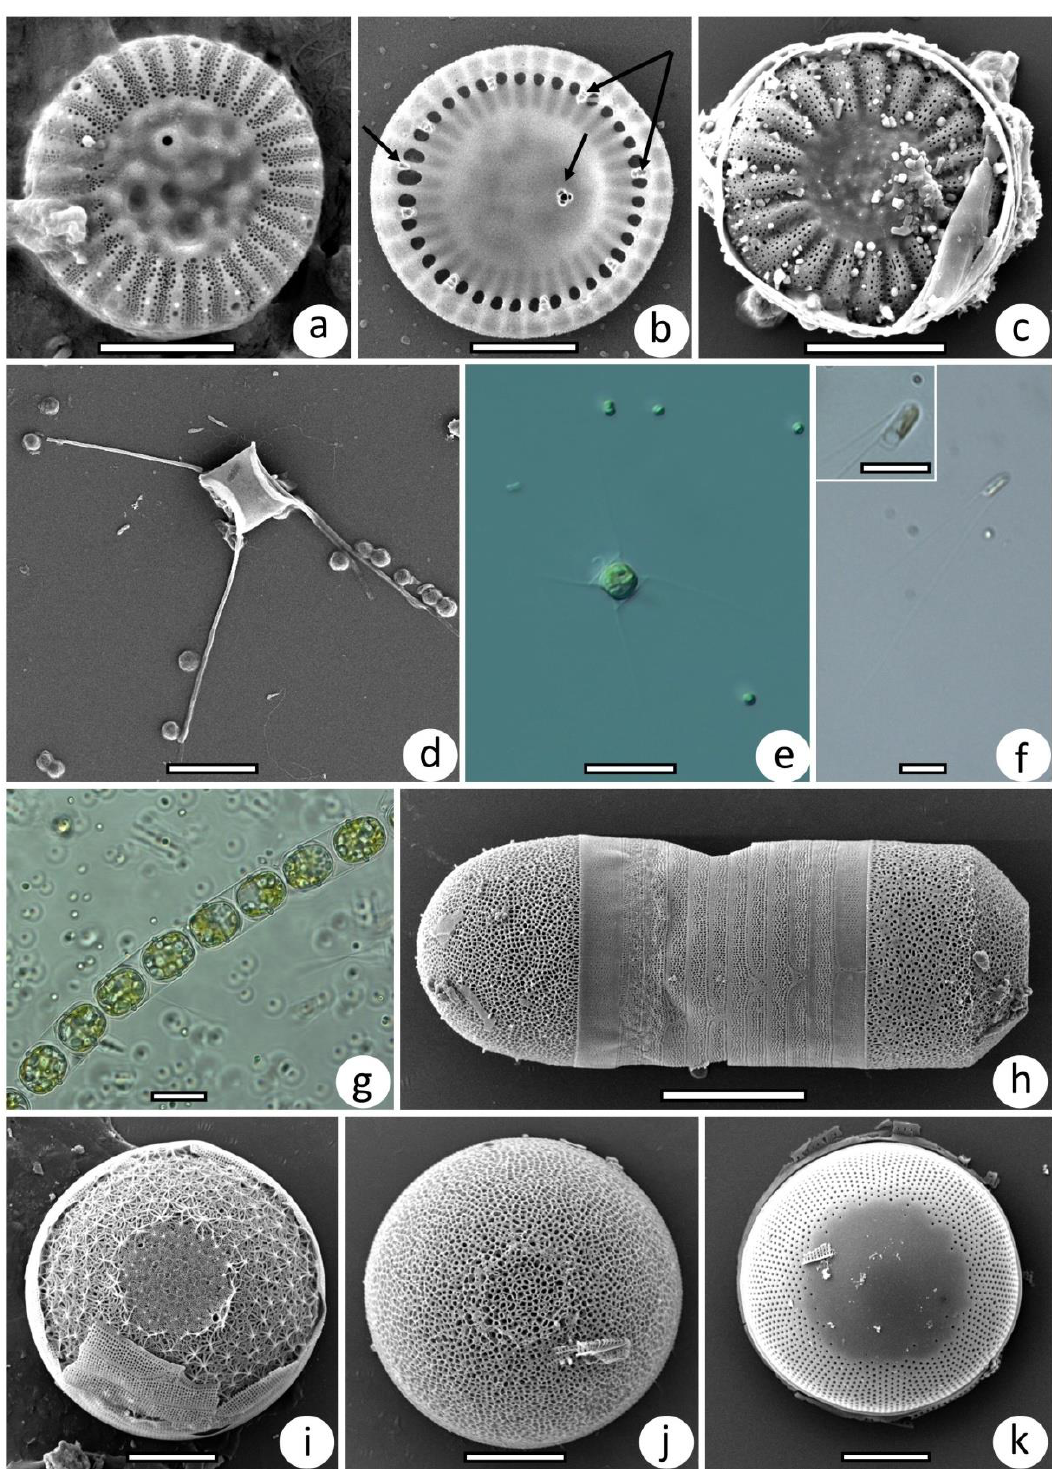
Figure 7. Morphology of the diatoms observed (LM ( e – g ); SEM ( a – d , h – k ): ( a , b ) Cyclotella choctawhatcheeana ( a — external view of valve; b — internal view of valve, arrows indicate central fultoportula with three satellite pores, marginal fultoportulae with two satellite pores, and rimoportula (arrow on the left)); ( c ) Cyclotella meneghiniana ; ( d , e ) Chaetoceros sp. 1; ( f ) Chaetoceros sp. 2; ( g – j ) Melosira nummuloides ; ( k ) Podosira stelligera . Scale bars: 2 µm — a , b ; 5 µm — c , i – k ; 10 µm — d – f , h ; 20 µm — g .